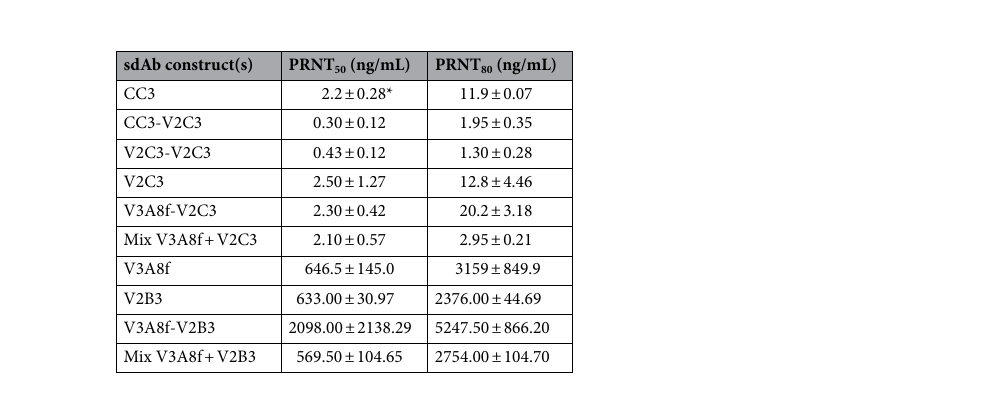
Table 6. Neutralization of CHIKV with standard and bivalent sdAb.